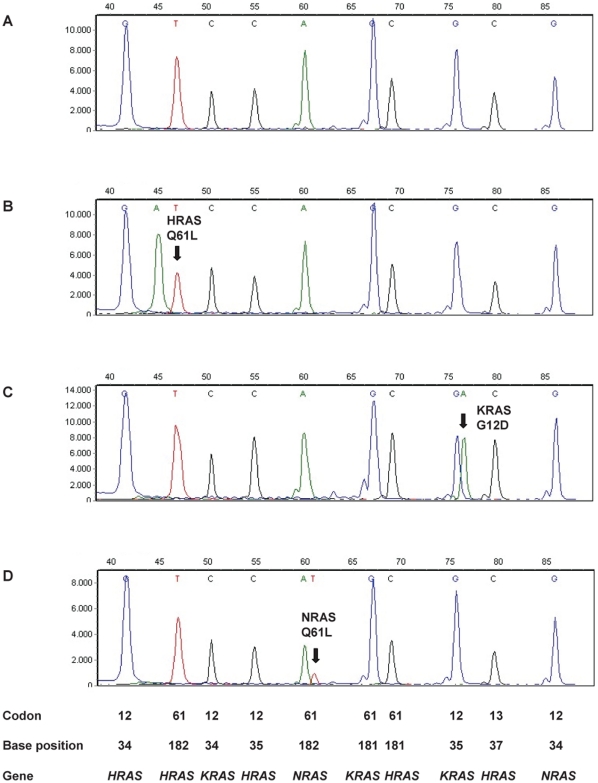
RAS-BC mutation assay.Panel A: wild-type sample, panels B–D: samples with mutations. Position of the interrogated codons, nucleotides and genes is depicted at the bottom.